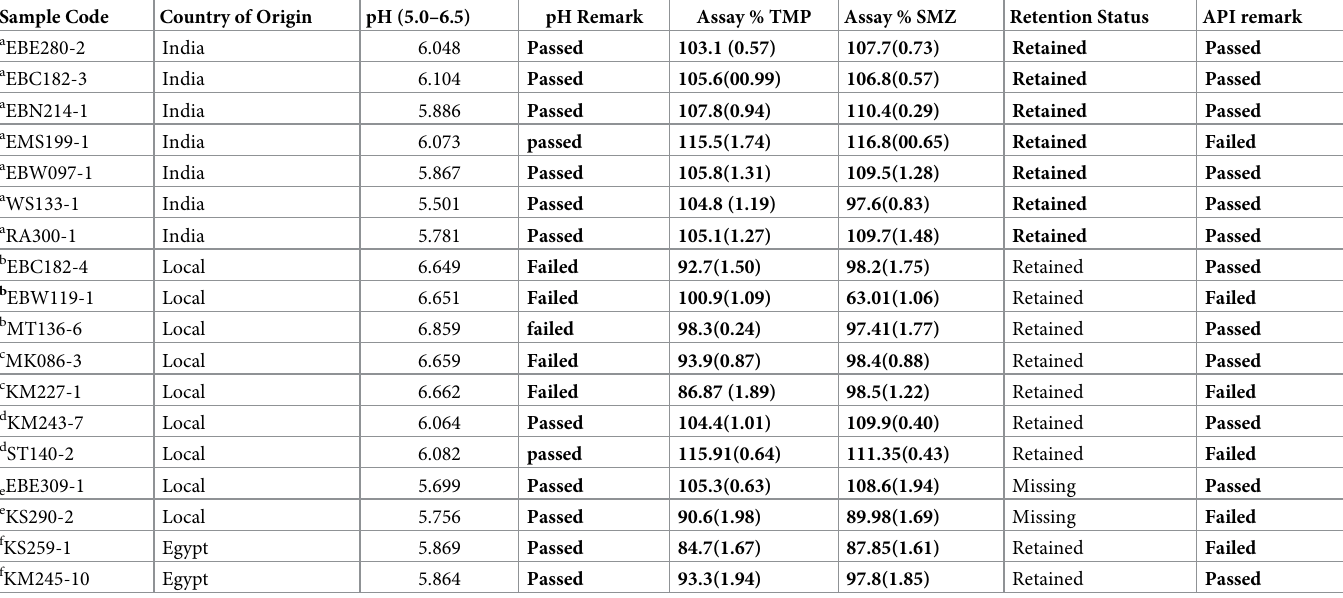
Table 3. Results for samples with intra-batch variation: Active pharmaceutical ingredient, pH and retention status.